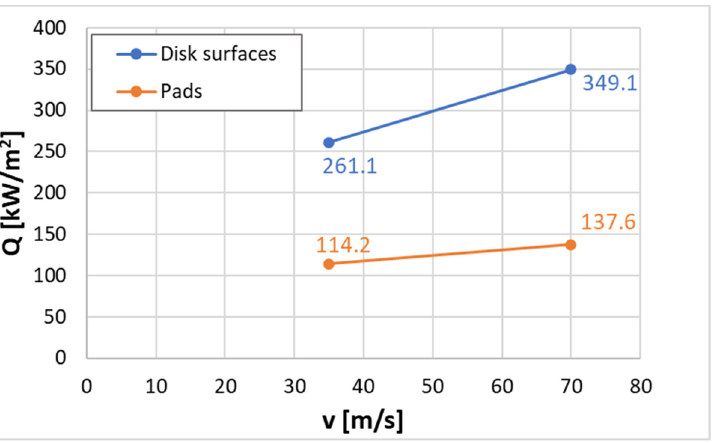
Figure 16. Heat flux removed from the main components at different car speeds—thermal convection and radiation.